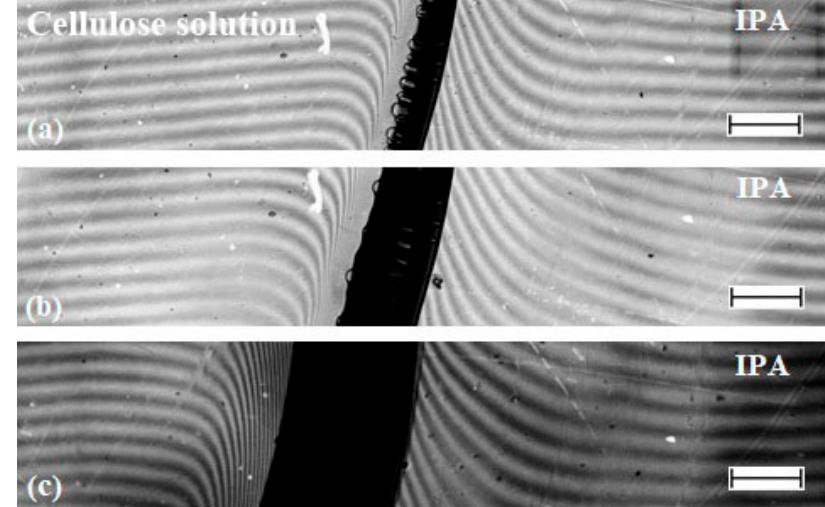
Figure 12. Interferograms of the contact zone of cellulose solution-isopropanol at a temperature of 90 °C. Time from the moment of reagents contact: ( a ) 1 min; ( b ) 3 min; and ( b )-10 min. The scale bar length is 250 μ m.